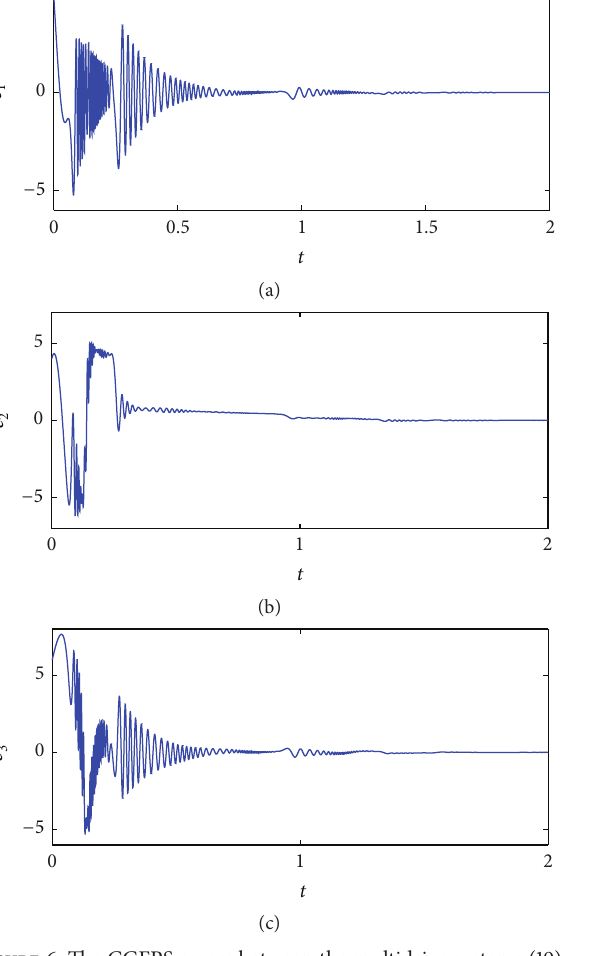
Figure 6: The CGFPS errors between the multidrive systems (19)– (21) and the response system